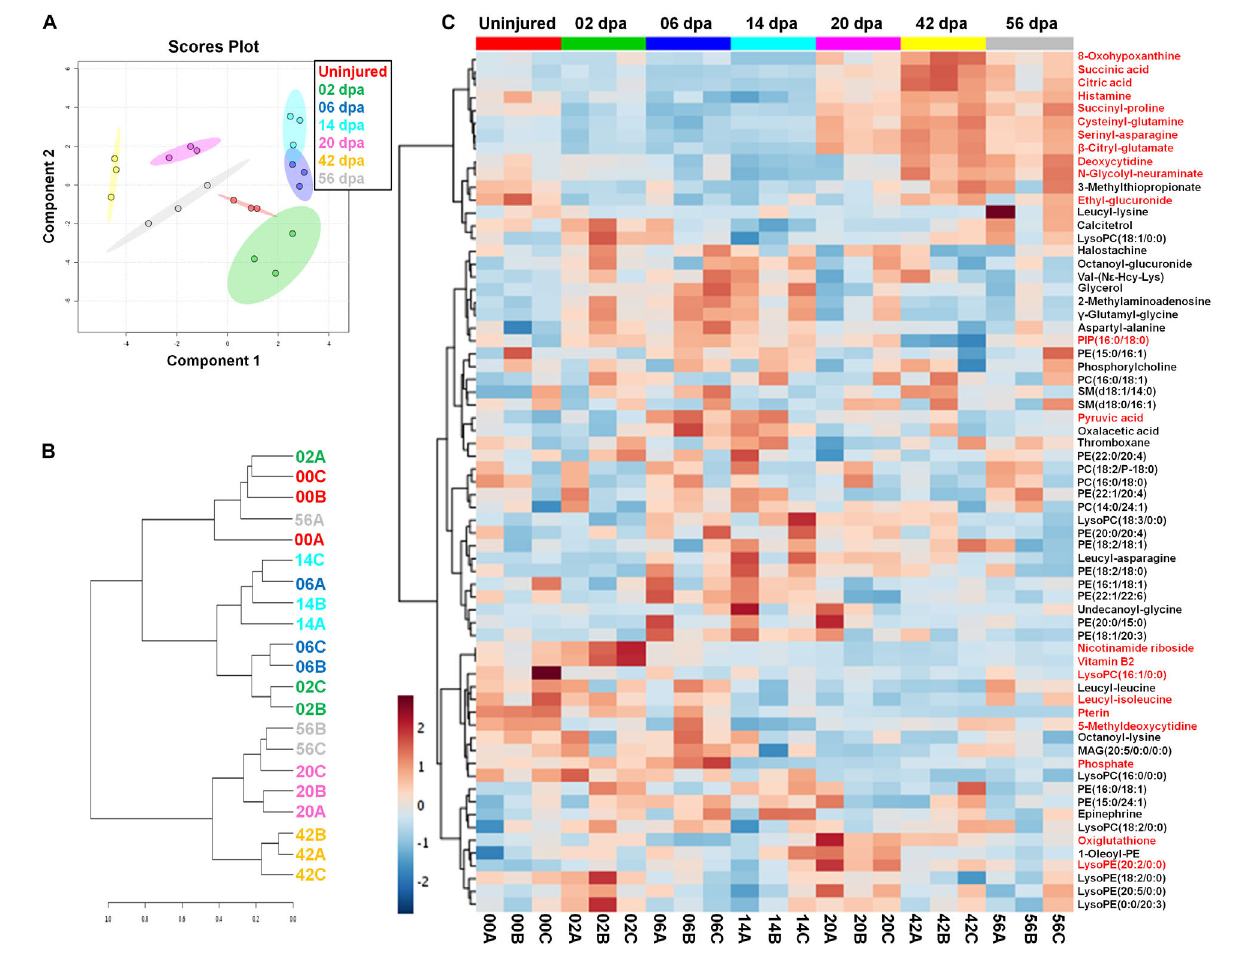
FIGURE 10 | Metabolic profiling during the regeneration process. (A) Clustering of metabolite samples evaluated by Sparse Partial Least Squares-Discriminant Analysis (sPLS-DA) with 5-fold Cross-Validated threshold. The stages are highlighted in different colors, displaying regions with a 95% confidence for samples grouped. (B) Hierarchical clustering dendrogram for metabolite samples analyzed through a Spearman distance measure and Ward clustering linkage. The stages are shown with different colors. (C) Heatmap of normalized abundances for pre-identified metabolites during regeneration. The metabolite abundances highlighted in red have a P < 0.05; one-way ANOVA with post hoc Tukey–Kramer test vs uninjured condition. Hierarchical clustering of metabolites was made using a Euclidean distance measure and the Ward clustering